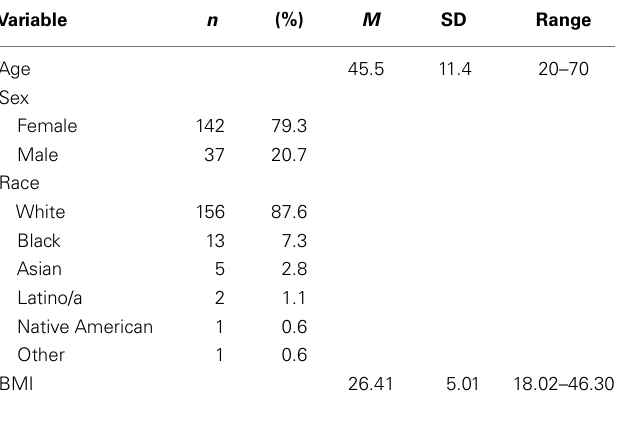
Table 2 | Baseline demographic characteristics of sample ( n = 179) .